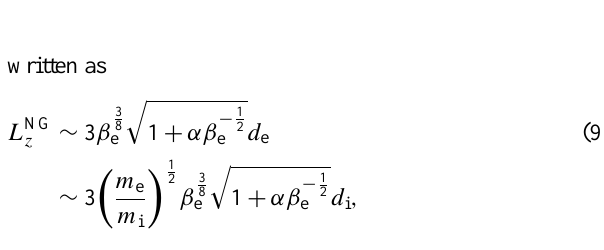
Figure 7. Cuts from the white dotted line in Fig. 2c of E rec y (a) and E NG y (b) for Runs 2 (red), 5 (green) and 8 (blue), and m e U e x ∂U e x ∂P e xx − 1 and eU e y B z for Run 2 (c) . Vertical lines in Fig. 7a–c n e ∂x show the location of | X | = L Df x ∼ L NG x for Run 2.